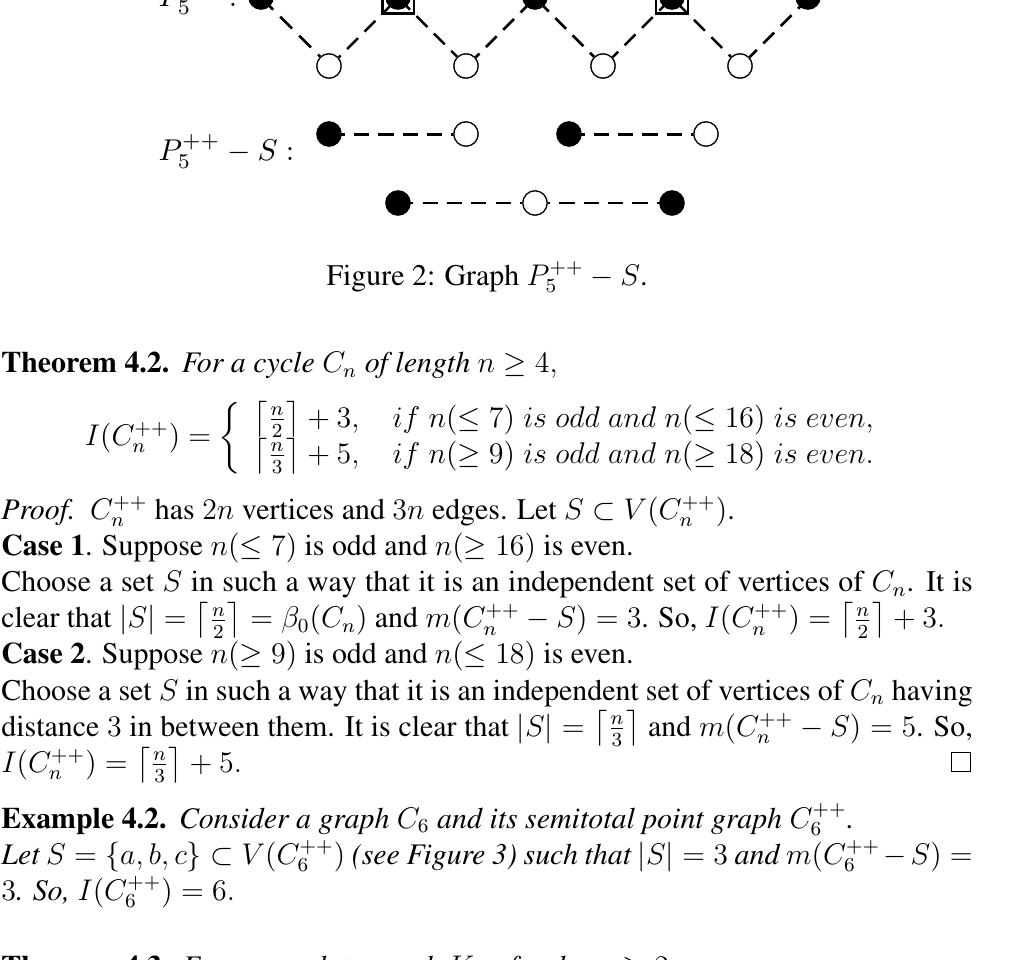
Figure 2: Graph P ++